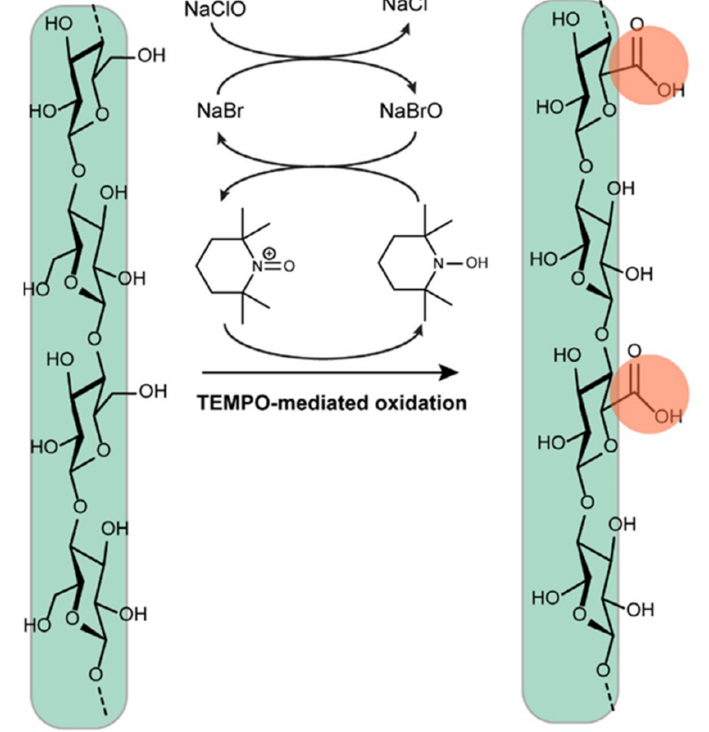
Figure 8. Schematic illustration of the TEMPO-mediated oxidation where it selectively transforms C6-hydroxy groups of nanocellulose to carboxylate groups (Ghasemlou et al. 2021; with permission from Elsevier Science Ltd., Amsterdam,